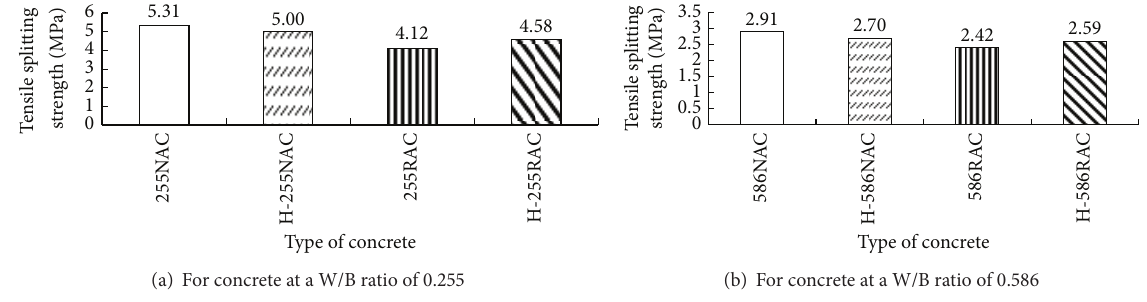
Figure 5: Tensile splitting strength of concrete at W/B ratios of 0.255 and 0.586.